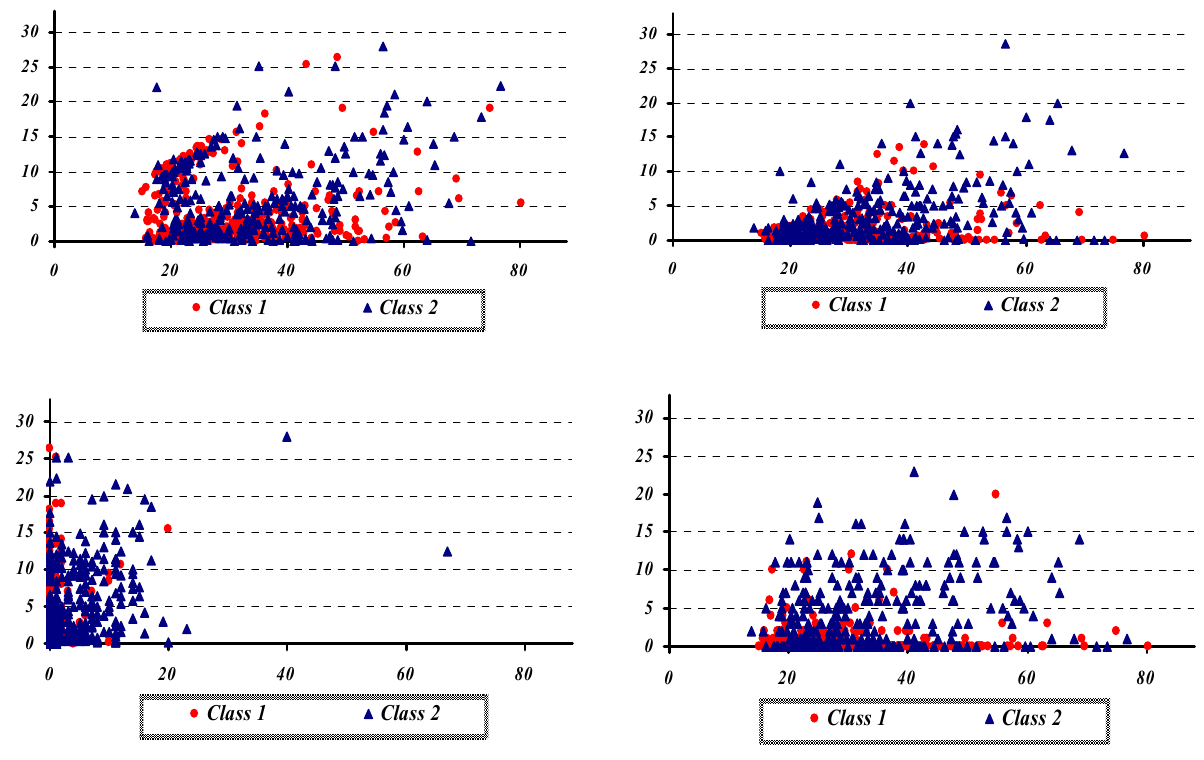
Figure 1. The two-dimensional distribution of the Australian credit cards